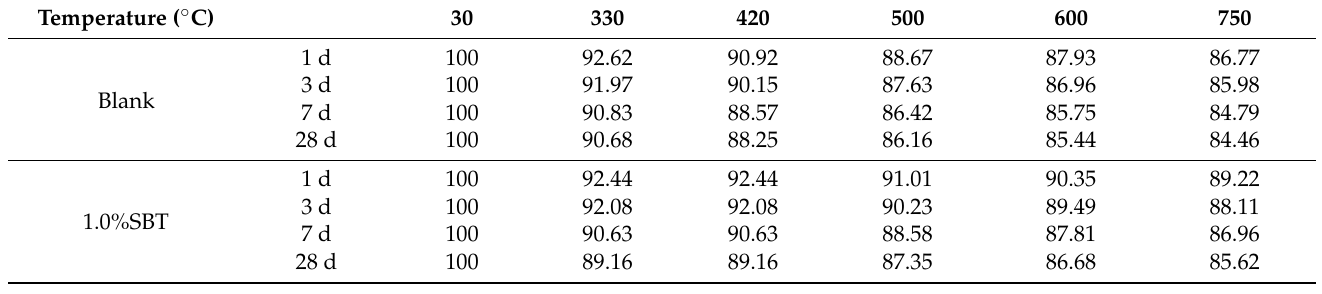
Figure 7. The degree of hydration of MgO at each age.